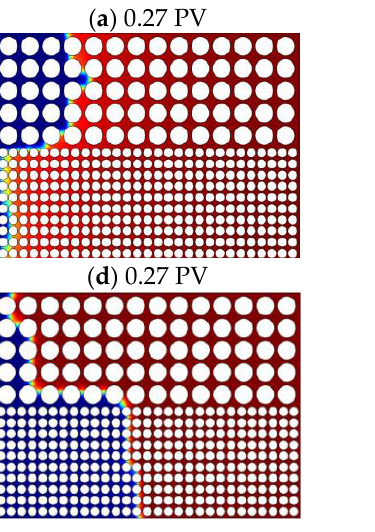
Figure 2. Distribution of oil saturation for different wettability. (The polymer solution is represented in blue and the oil in red).